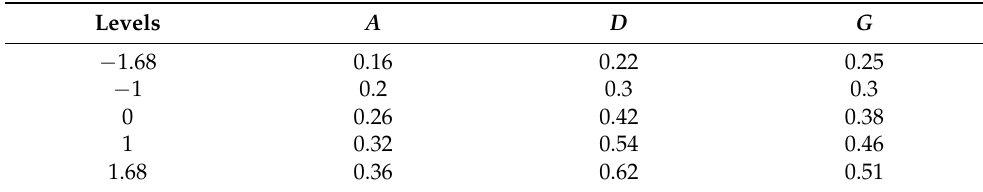
Table 6. The encoding values of the significant influencing factors (the Poisson’s ratio of FJF A , the static friction coefficient of FJF–FJF D and the static friction coefficient of FJF–steel plate G ) with a central composite design.